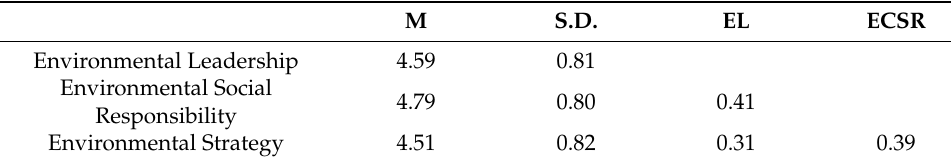
Table 2. Means, standard deviations, and correlations.